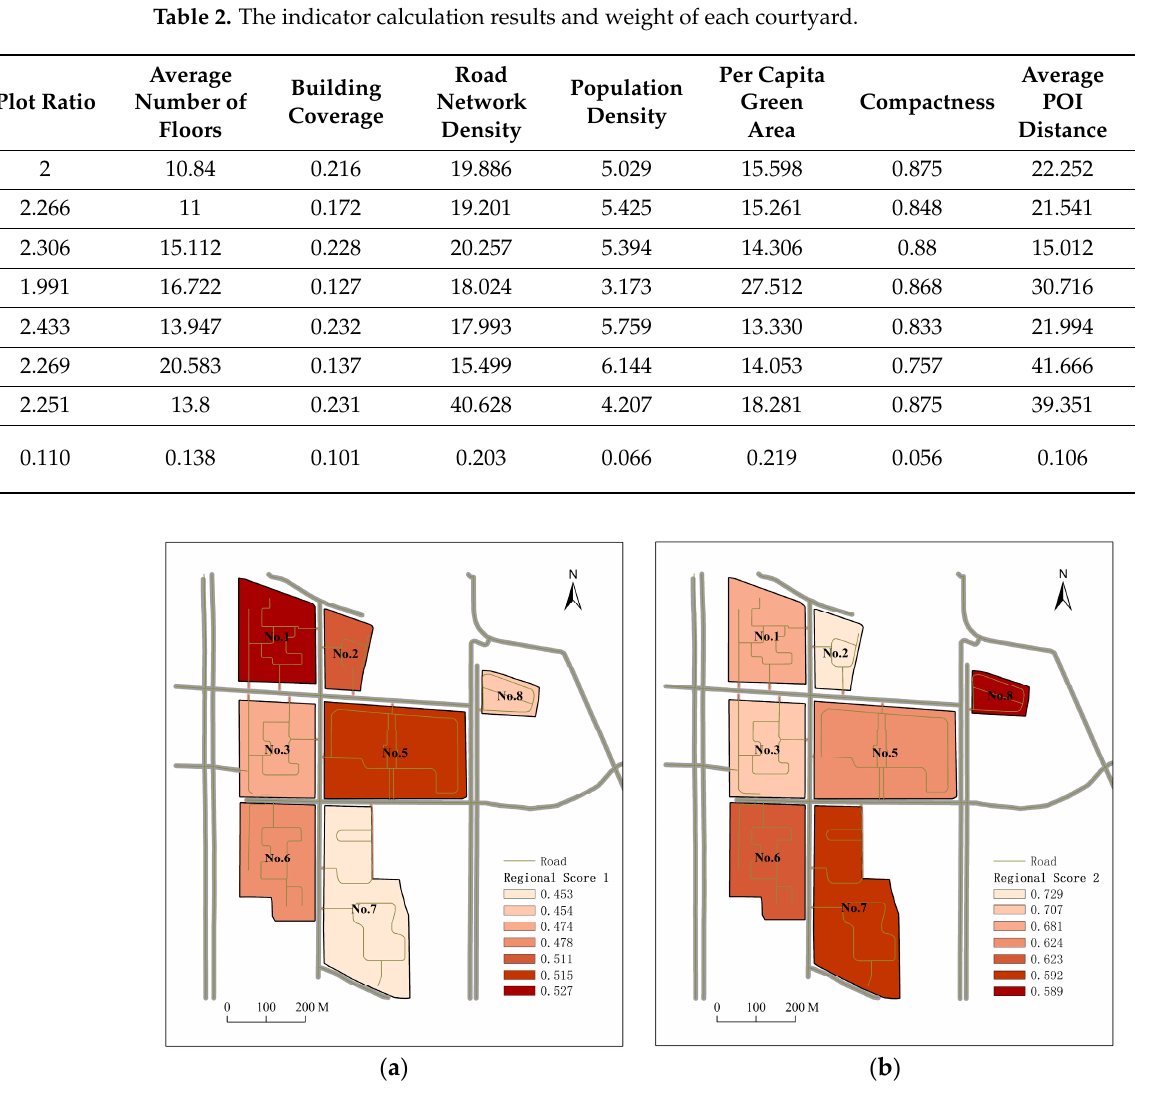
Figure 7. The regional score results for different indicator types: ( a ) livability of the space (Score 1 determines the type of indicators based on benefits during calculation. The darker the color of the demonstrated results, the more livable the district is), ( b ) degree of spatial cognition (In score 2, the indicator type is evaluated based on the influence degree of the spatial cognition. The darker the color in the plotted results, the more substantial the heterogeneity of the district, and the easier it is to promote residents to form cognition).